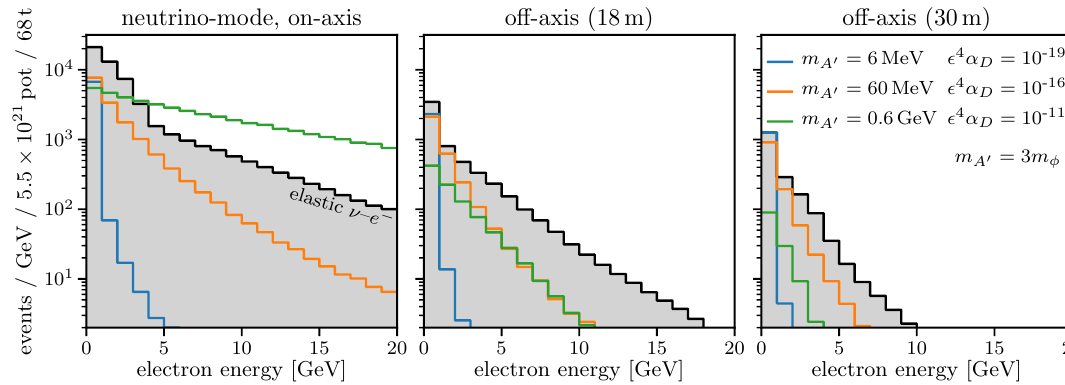
Figure 2 . Signal and background spectra in DUNE-PRISM for the dark photon model after 5 years of data taking ( 5 . 5 × 10 21 pot ) in neutrino mode. Colored histograms show the DM-electron scattering signal for different exemplary sets of model parameter points, imposing m gray shaded background histogram is based on a simulation of elastic neutrino-electron scattering. Comparing data taken all on-axis (left panel) to data taken at 18 m ( 31 . 36 mrad ) off-axis (center panel) or 30 m ( 52 . 26 mrad ) off-axis (right panel), we see that, as expected, both the signal and background rates are significantly lower in the off-axis positions, especially at high energy. At low energies, where most of the events are concentrated, the signal-to-background ratio becomes better when going